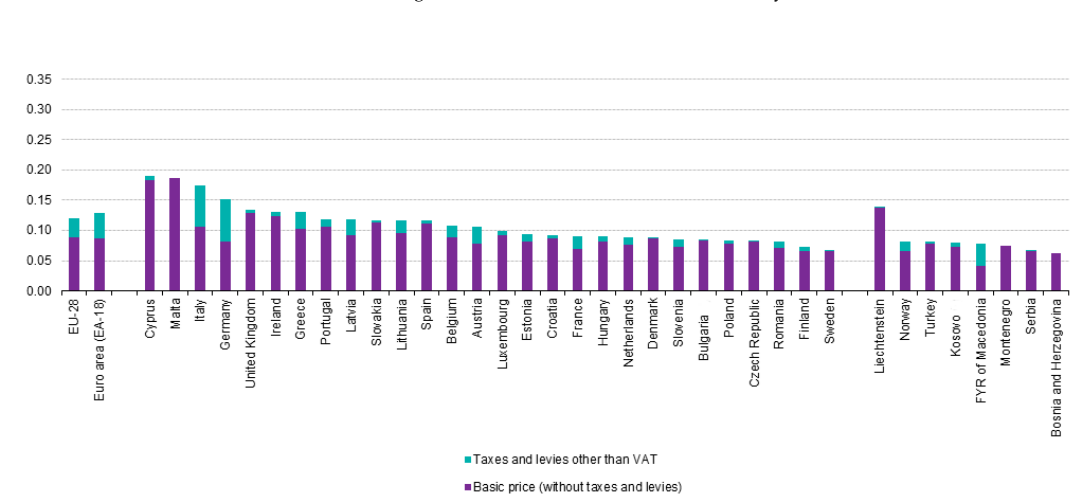
Figure 3. Energy prices in €/kWh for industrial consumptions among 500 and 2000 MWh/year [38].